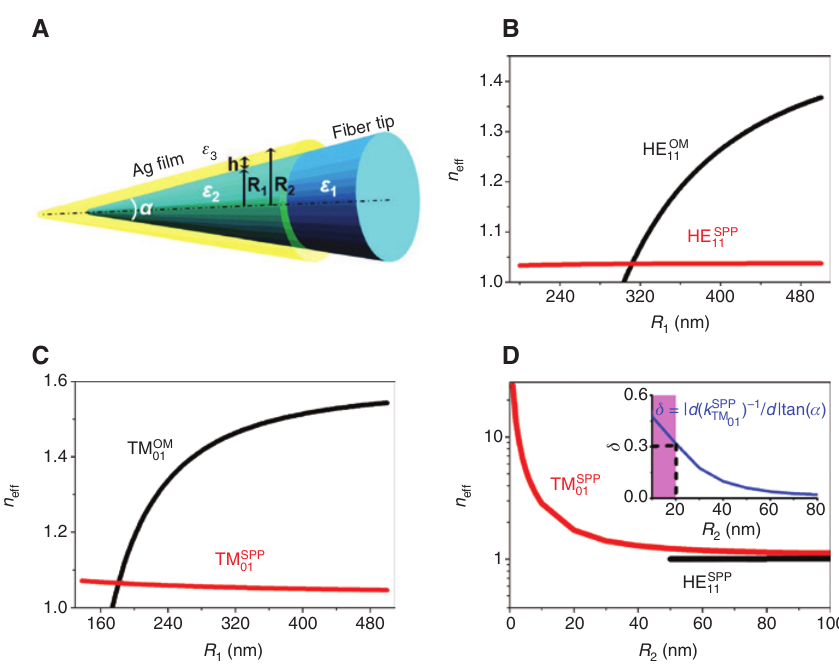
Figure 1: Design of Ag-coated fiber tip for nanofocusing. (A) Sketch map of an Ag-coated fiber tip. Dielectric constants of the fiber tip, the Ag film and the surrounding are ε The conical angle and the radius of the fiber tip are α and R SPP HE as a function of R 11 SPP TM as a function of R 01